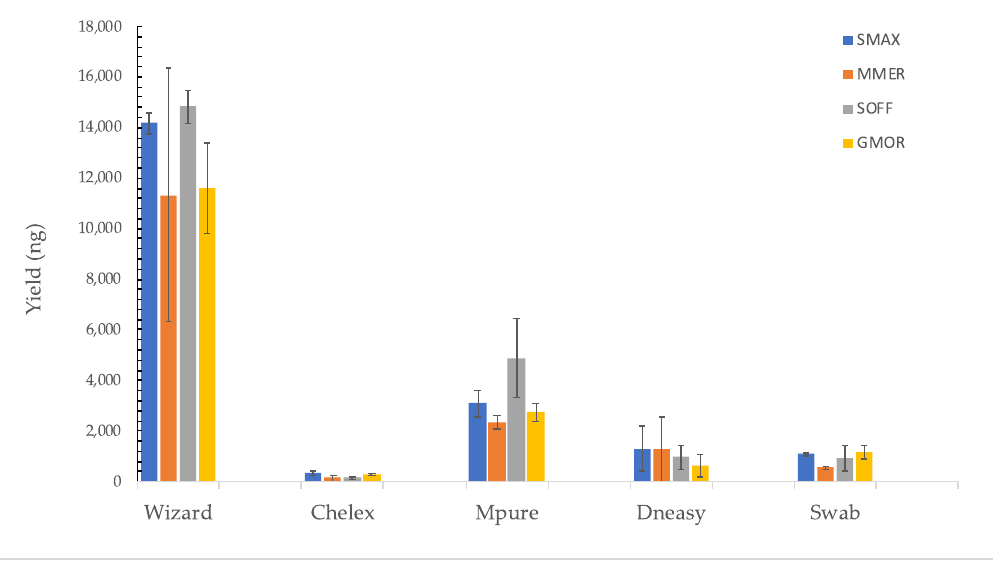
Figure 2. Yield (ng) of the tested methods per species. Data are presented as mean ± SD of individuals per species. Scophthalmus maximus (SMAX), Merluccius merluccius (MMER), Sepia officinalis (SOFF) and Gadus morhua (GMOR).